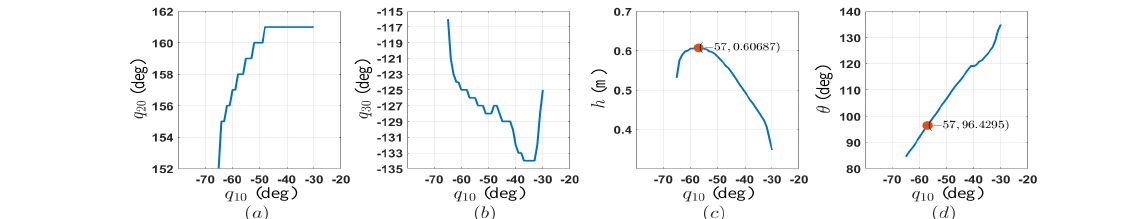
Figure 9. ( a ) optimal knee angle q 20 for various initial values of ankle angle q 10 ; ( b ) optimal hip angle q 30 for various initial values of ankle angle q 10 ; ( c ) maximum jump height h for various initial values of ankle angle q 10 ; ( d ) jump direction θ for various initial values of ankle angle q 10